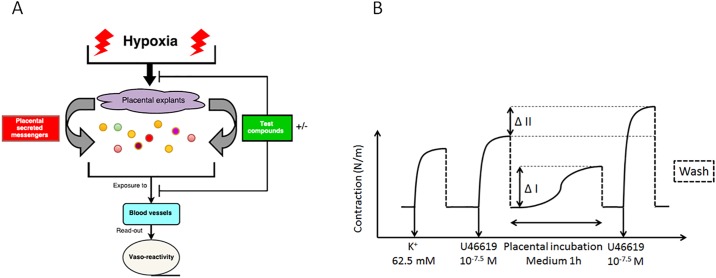
In vitro model for severe placental hypoxia and testing the vascular effect of PSMs.Schematic overview of the In vitro model for PE where placental explants are exposed to severe hypoxia and PSMs are tested on chorionic arteries. Differences in contractile response are used as read-out (A) and a schematic overview for measuring the acute (ΔI) and sustained (ΔII) vascular effect of PSMs (B).